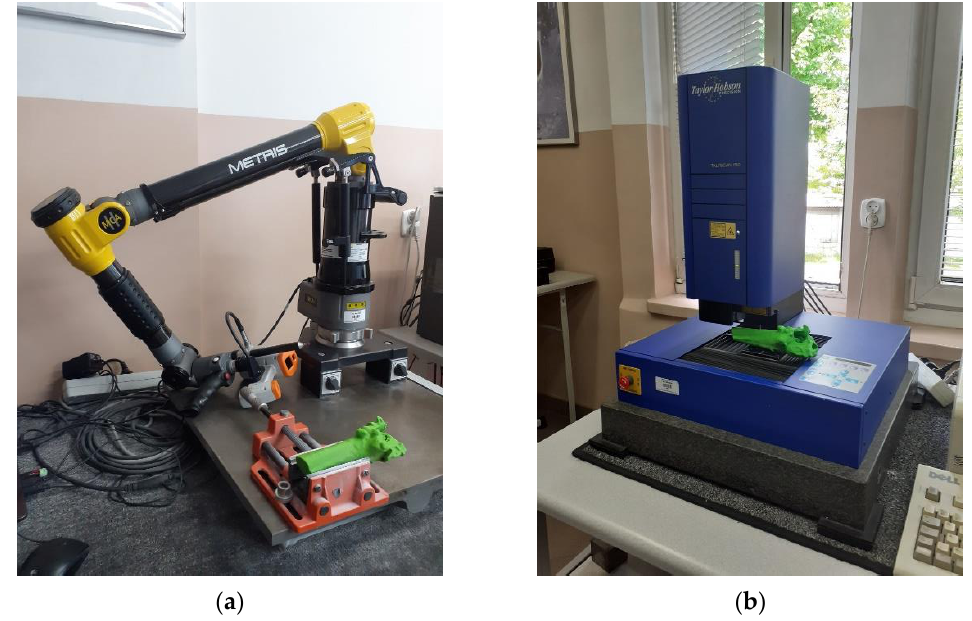
Figure 15. Measuring systems: ( a ) MCA-II measuring arm with the MMD×100 laser head, and ( b ) 3D Talyscan 150 profilometer.